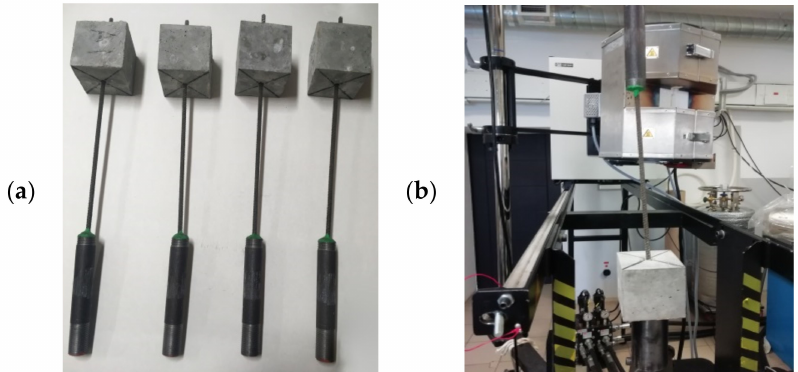
Figure 5. Equipment and specimens for testing an adhesion of the basalt-plastic reinforcement bars d = 10 mm with a mortar cube 100 × 100 × 100 mm: ( a ) test specimens, and ( b ) test specimen in a movable frame of an Instron 8802 dynamic testing